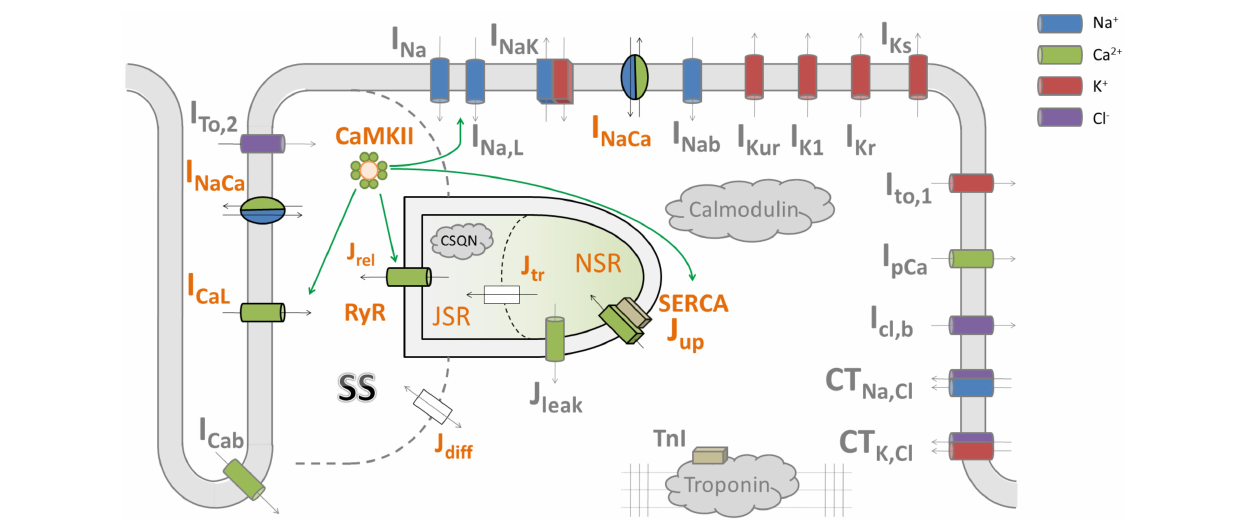
FIGURE 1 | A diagram of the HeRd model of ventricular cardiomyocyte and an overview of calcium handling. Shown are transmembrane currents, compartmentalized sarcoplasmic reticulum and the associated fluxes, and CaMKII signaling. β -adrenergic signaling components in the model were not used in this study. The calcium handling components relevant for alternans are highlighted in orange font. Green arrows indicate which components are regulated by CaMKII, an important regulator of calcium handling. Within an action potential, calcium handling in the model works as follows: L-type calcium current (I CaL ) induces an influx of calcium which is sensed by ryanodine receptors (RyR). This induces a large-magnitude release of calcium, J rel , via RyR (this process is termed CICR: calcium-induced calcium release). The amount of calcium released via RyR depends mainly on the calcium stimulus via I CaL and the load–release relationship of junctional sarcoplasmic reticulum containing RyR (JSR): the fuller the JSR is, the more calcium it releases (Shannon et al., 2000). This relationship is steep, as shown in a previous study of the Hund-Rudy model (Livshitz and Rudy, 2007) and experiments (Shannon et al., 2000), i.e., a relatively small increase in JSR contents may increase fractional release considerably. The released calcium then diffuses to the intracellular space (J diff ) and eventually to SERCA pumps, which reuptake the calcium back to network sarcoplasmic reticulum containing SERCA pumps (NSR). Ultimately, within sarcoplasmic reticulum, calcium diffuses from NSR to JSR along the concentration gradient (J tr ), from where it may be released in the next action potential. SS codes the junctional calcium subspace where the calcium influx via ICaL stimulates ryanodine receptors. The figure is based on Heijman et al. (2011).